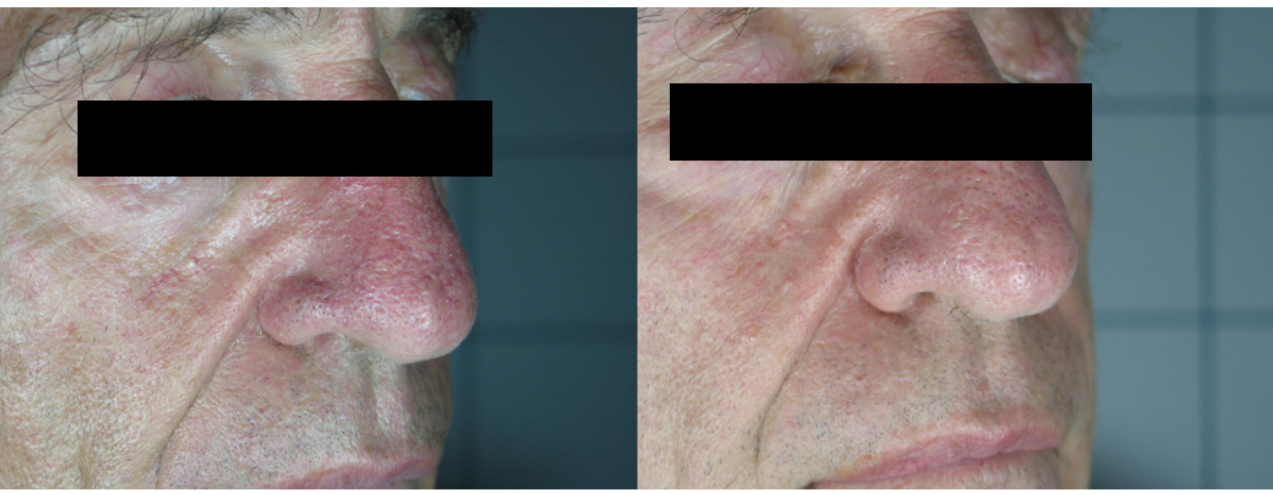
Figure 6. Patient n. 31 before (left) and 3 months after IPL treatment.